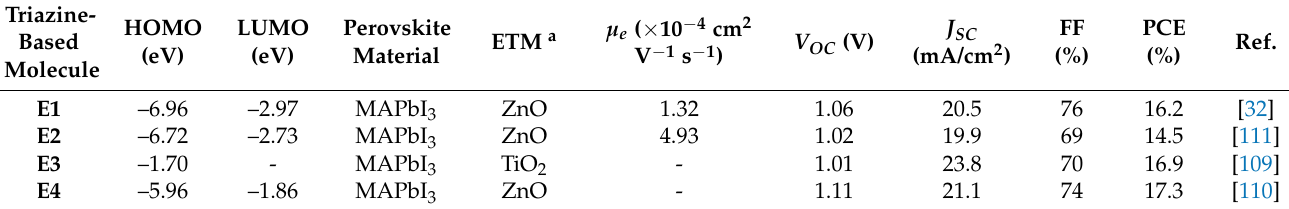
Table 5. Photovoltaic parameters of PSCs based on triazine-based molecules as